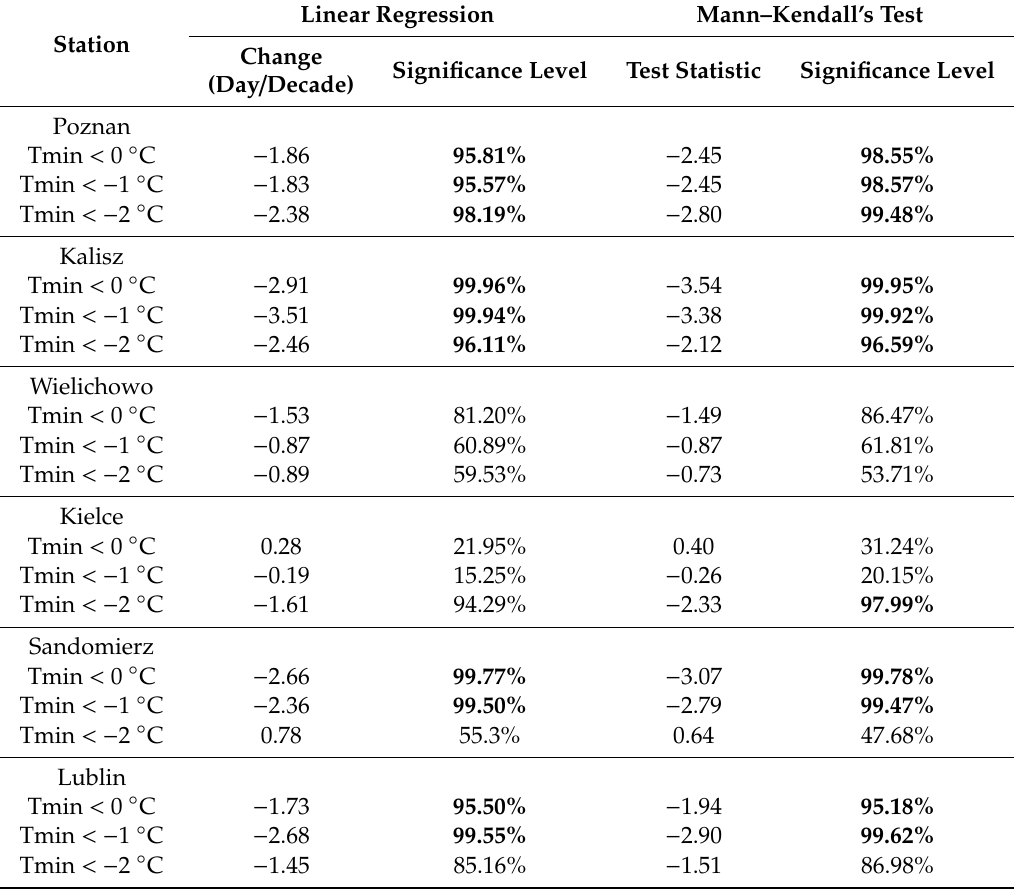
Linear Regression Mann–Kendall’s Test Station Change Significance Level Test Statistic Significance (Day / Decade)